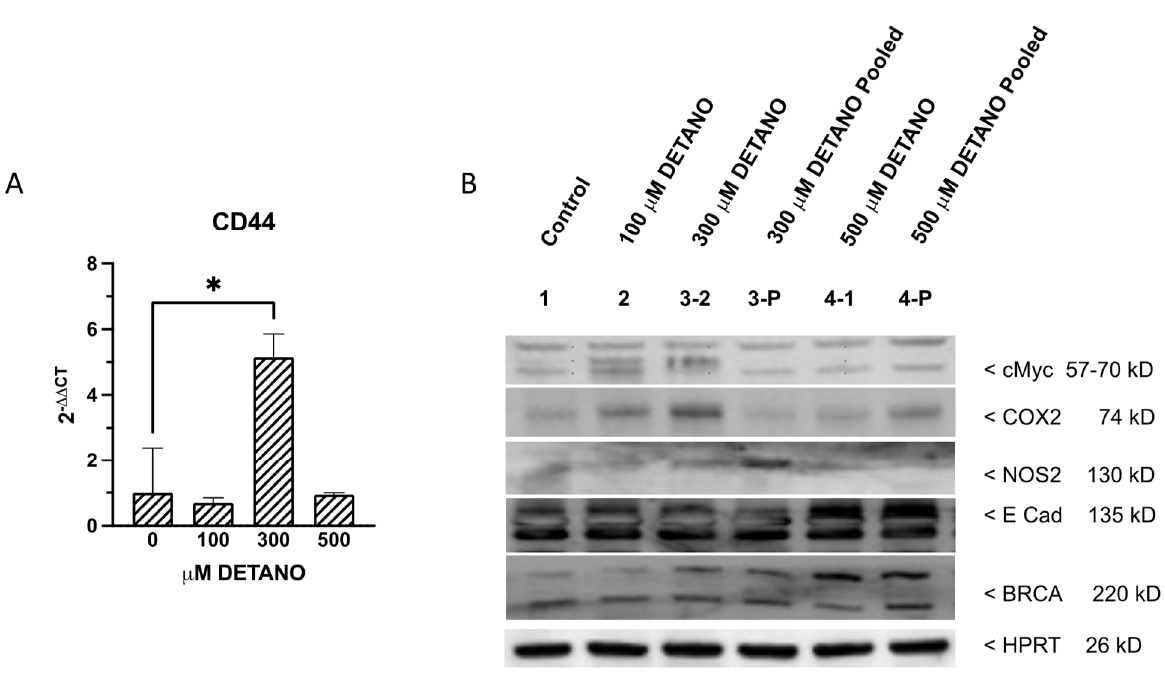
Figure 5. Quantitative Real-Time PCR Results of MCF10A cells following three weeks exposure to 0, 100, 300 or 500 μ M DETANO. ( A ) Chronic exposure to 300 μ M DETANO led to significantly increased CD44 expression, when compared to the untreated control. ( B ) Increased COX2 protein expression was observed in 100 and 300 μ M treated cells. Student t-test was used to determine statistical significance as defined by * p < 0.05.